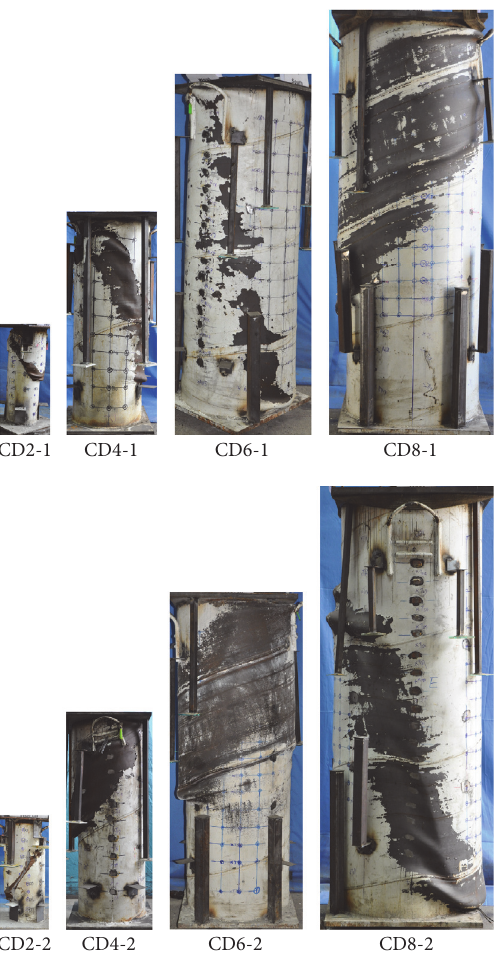
Figure 2: Appearance of each specimen at peak load. Figure 3: Final failure mode of each specimen.